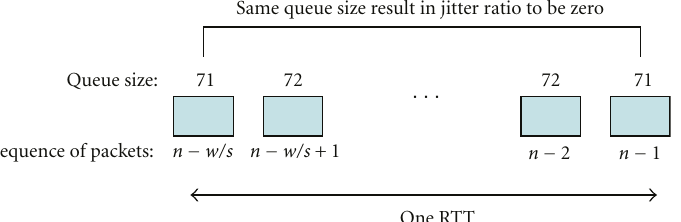
Figure 3: Ine ff ective jitter ratio calculation.